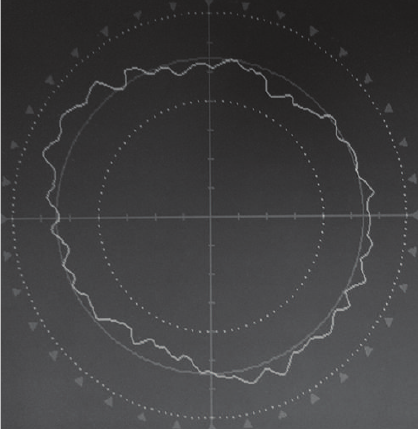
Figure 7: Out-of-roundness measurement results on ultrasonic burnished S355J2 steel. Ra0.35 and PV value 8.4 𝜇 m.